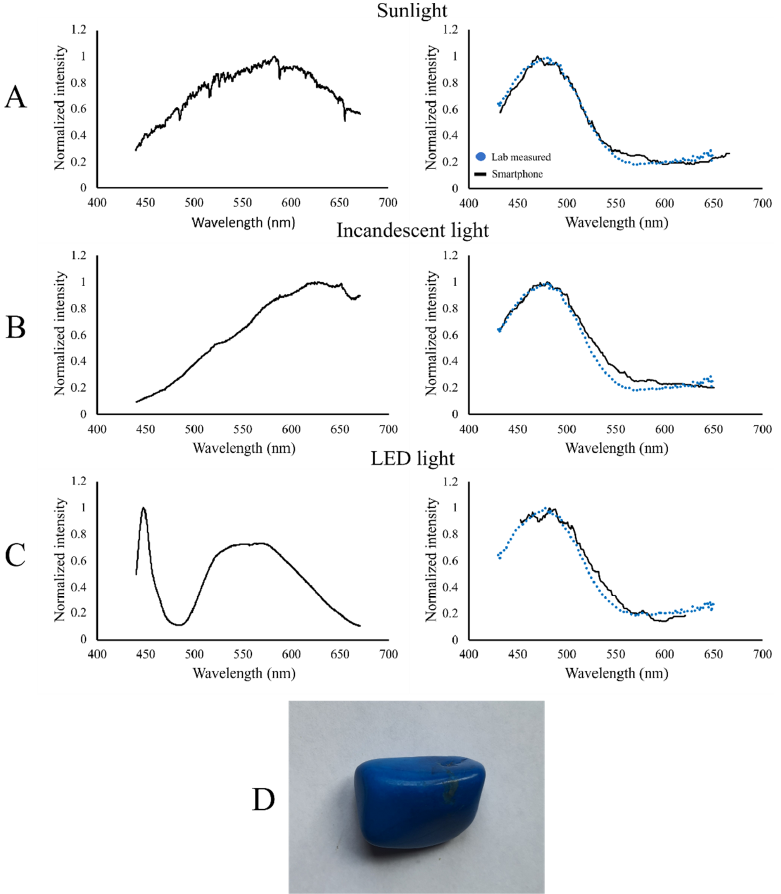
Figure 10. The spectra of the light sources (left) used during the acquisition of the reflection spectra of a sample of lapis lazuli and the measured reflection spectrum (right) with the lab-measured reflection spectrum overlayed in blue where the light sources were ( A ) natural sun light, ( B ) incandescent light and ( C ) LED light. ( D ) shows the sample of the lapis lazuli that was measured.